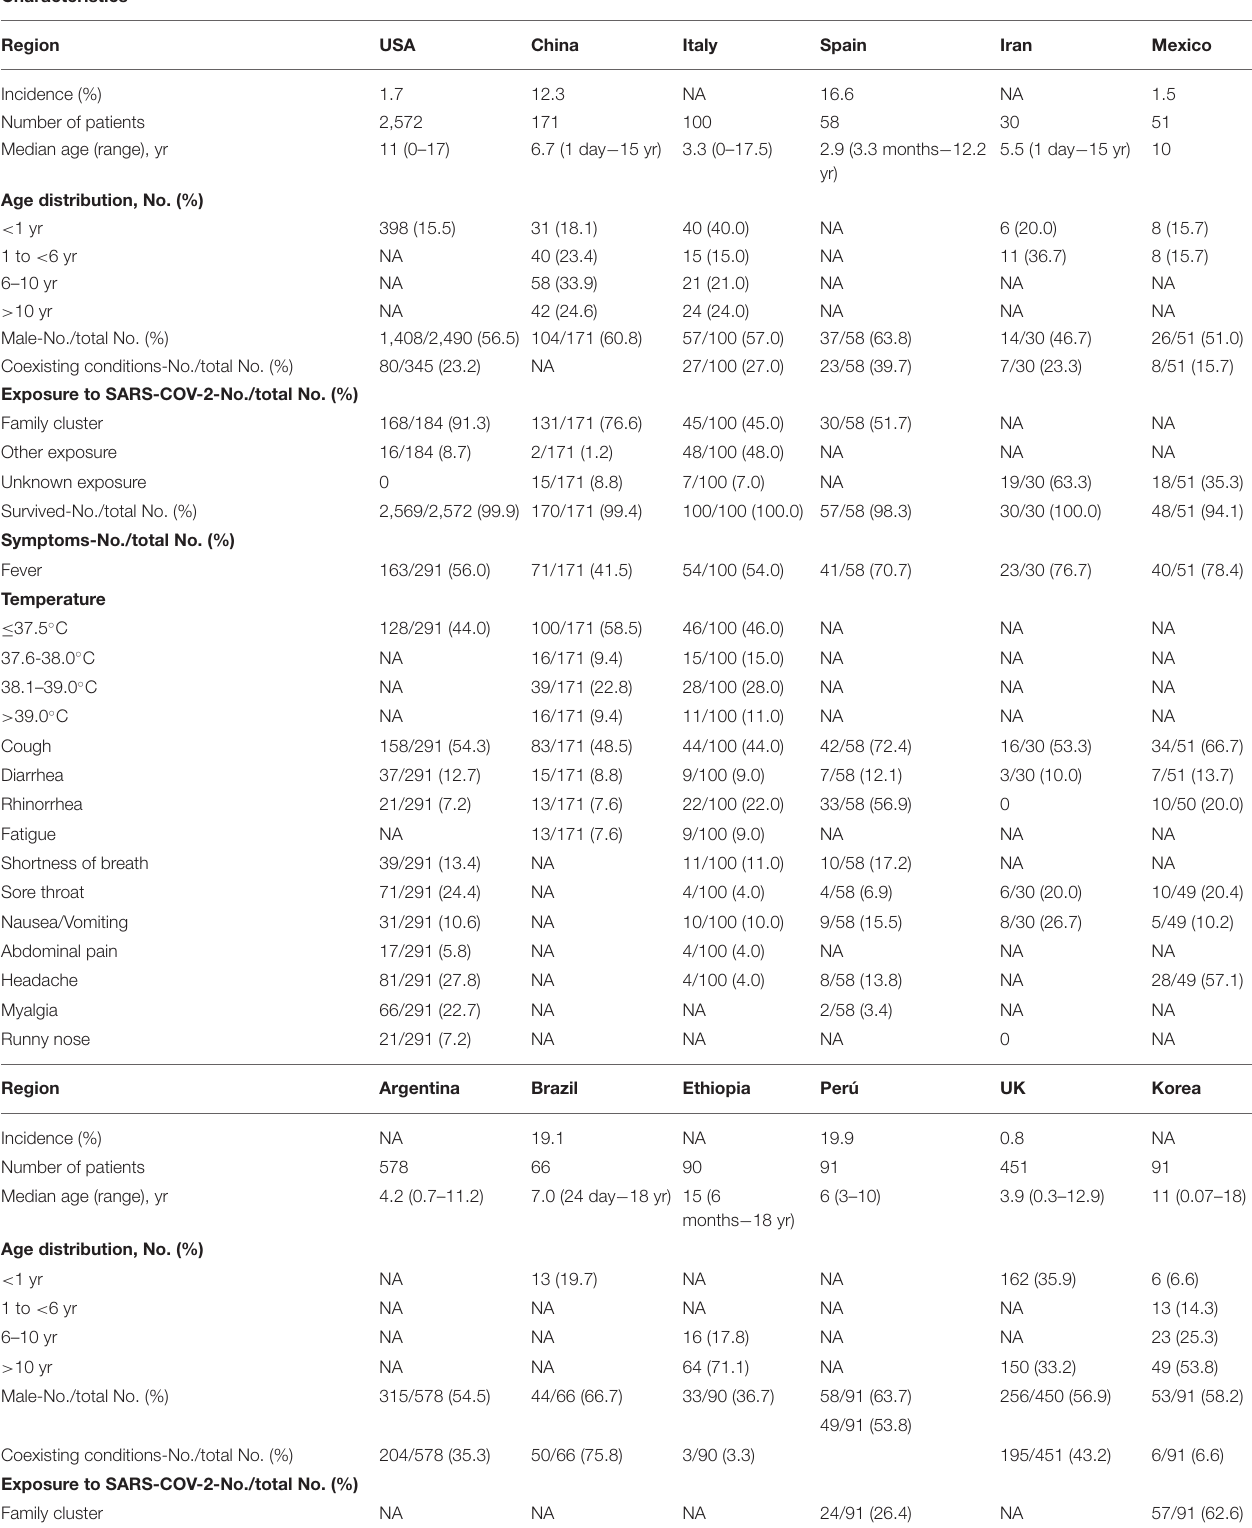
TABLE 1 | Clinical characteristics among COVID-19 pediatrics patients in different countries (27–38).